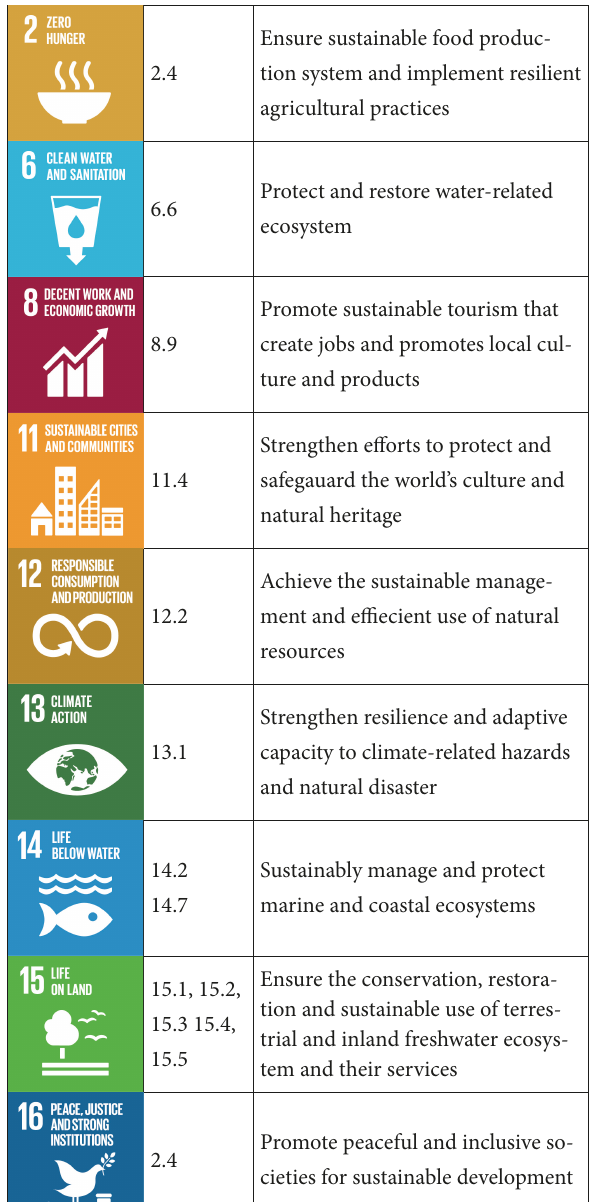
Table 3 Relevance of safeguarding and management of cultural landscapes to the 2030 Agenda for Sustainable Development (Source: